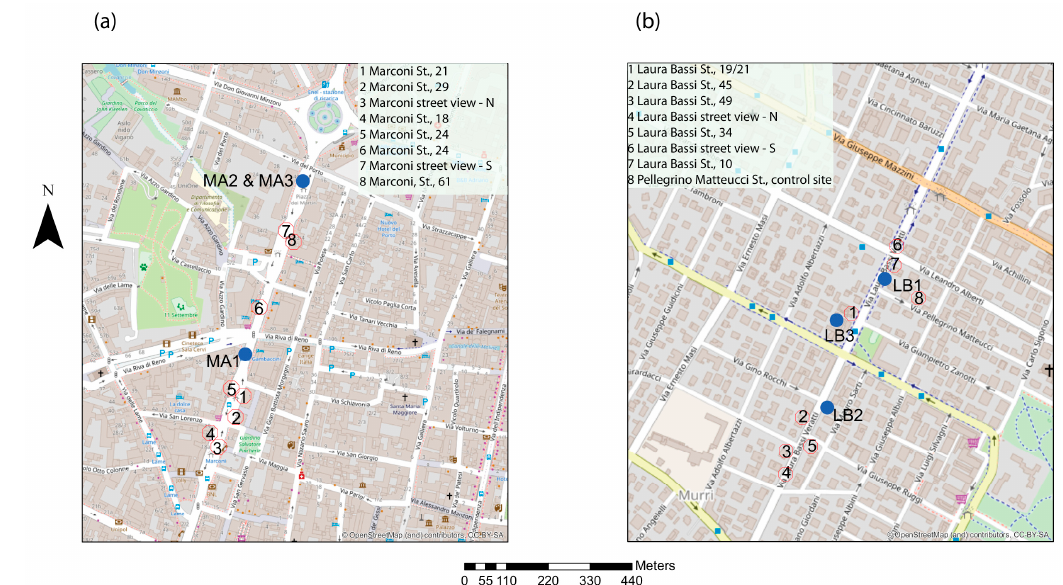
Figure 4. Positions of the monitoring sites (blue dots) and of the locations chosen for the temperature measurements of the building façades and of the ground surface during the two intensive thermographic campaigns in the two street canyons in Bologna (numbers within the red circles): ( a ) Marconi St. and ( b ) Laura Bassi St. (source: OpenStreet Map).